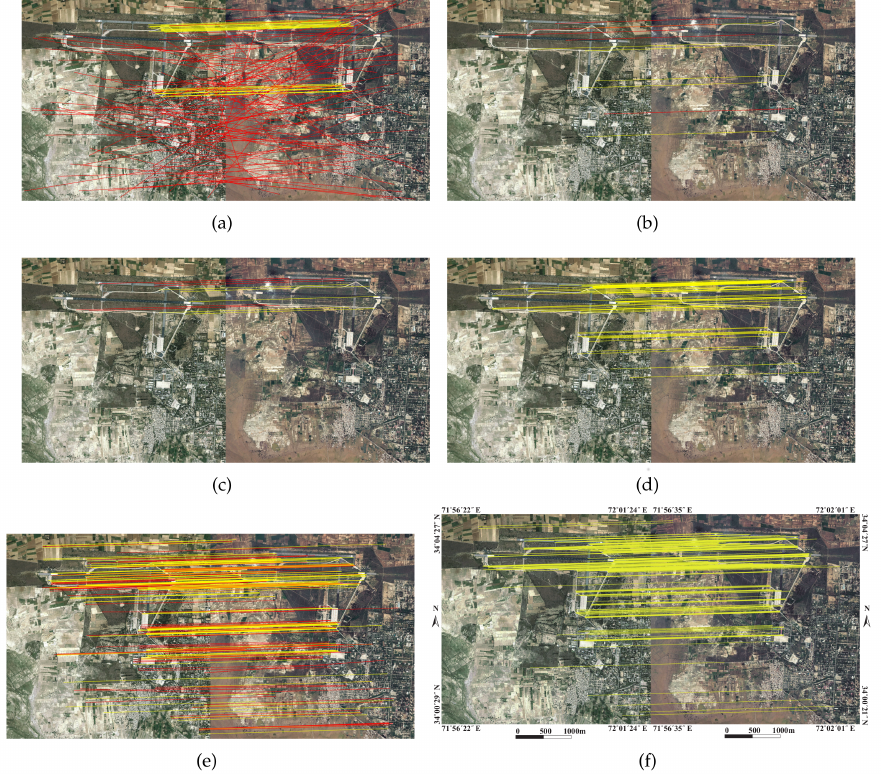
Figure 11. Matching results of image pair 3. ( a ) SIFT; ( b ) LP; ( c ) MSLD; ( d ) RLI; ( e ) LJL; ( f )